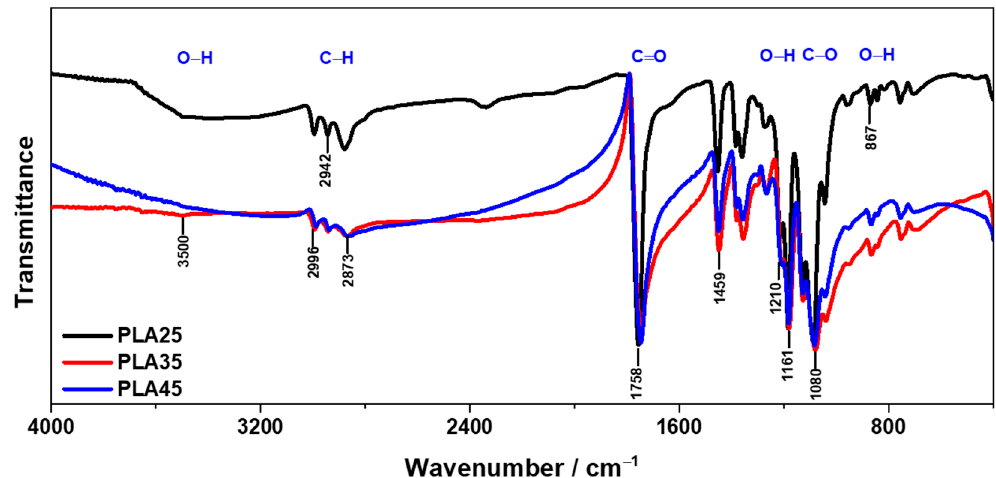
Figure 3. FTIR spectra of the three electrospun/electrosprayed PEG/PLA